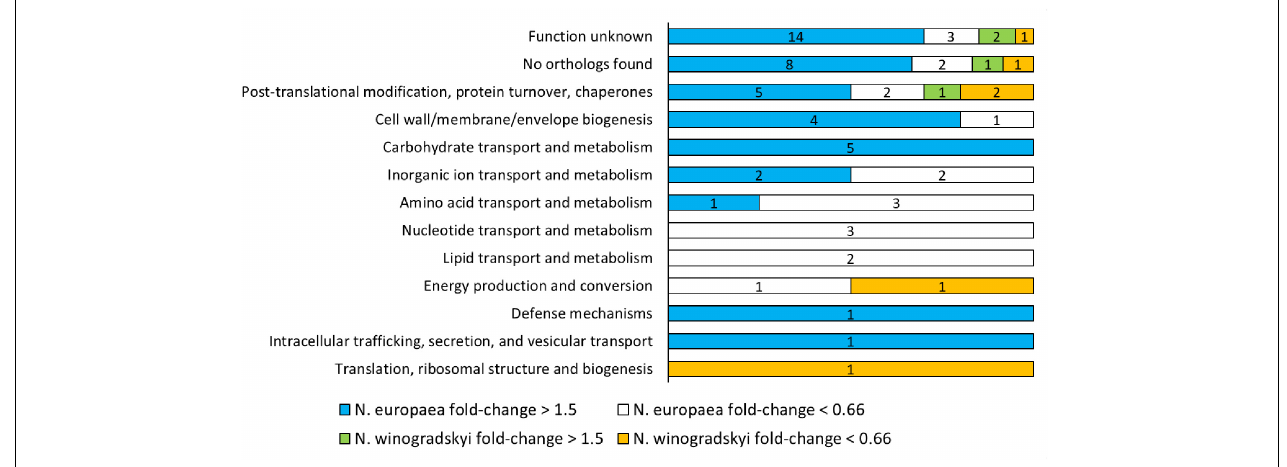
FIGURE 2 | Clusters of Orthologous Groups (COGs) classification of N. europaea and N. winogradskyi proteins with a significant fold change (higher than 1.5 or lower than 0.66; p < 0.05) after exposure to 30 mS cm − 1 .